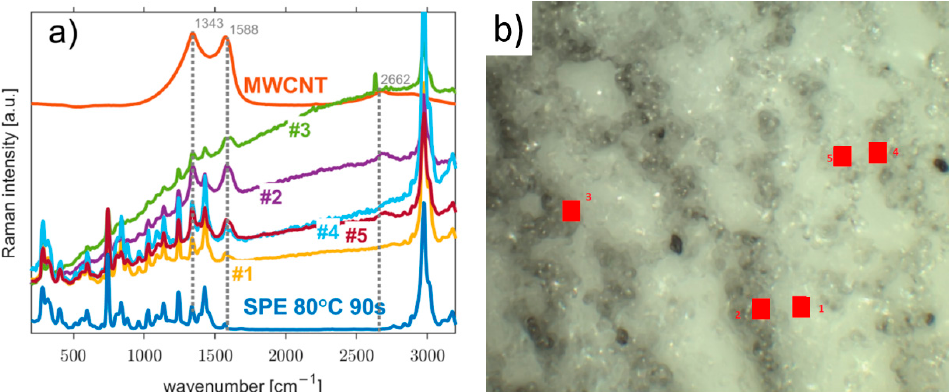
Figure 3. ( a ) Raman spectra of the MWCNT working electrode and solid polymer electrolyte (SPE treated at 80 °C for 90 s) and their mutual interface corresponding to marked positions from #1 to #5 at ( b ) confocal microscopy image of their acquisition locations.